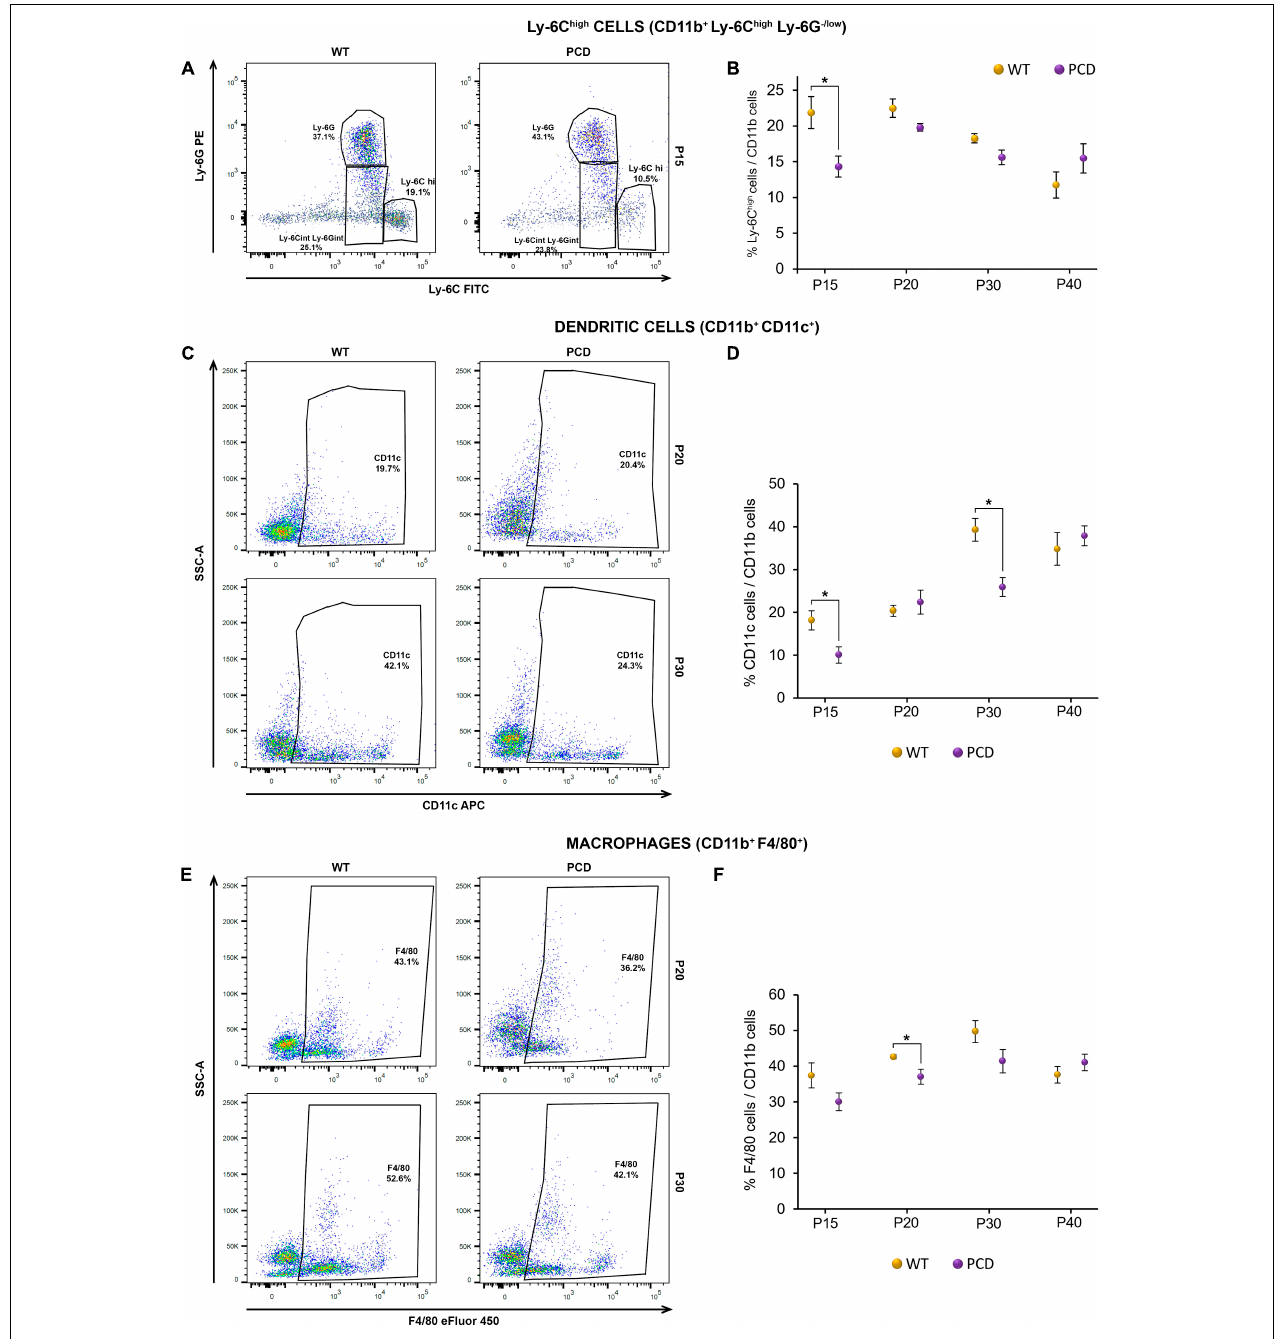
FIGURE 4 | Flow cytometry analysis of the percentage of different myeloid subsets in the spleen of WT and PCD mice. (A,C,E) Representative dot plots showing the Ly-6C high cell (A) , dendritic cell (C) and macrophage (E) content within the whole myeloid population after having excluded dead cells, debris and doublets. (B,D,F) Charts showing the percentage of the Ly-6C high cells (B) , dendritic cells (D) and macrophages (F) within the myeloid population. Note that PCD mice presented an overall reduction in the percentage of several myeloid populations. Data are expressed as mean ± standard error of the mean. * p <